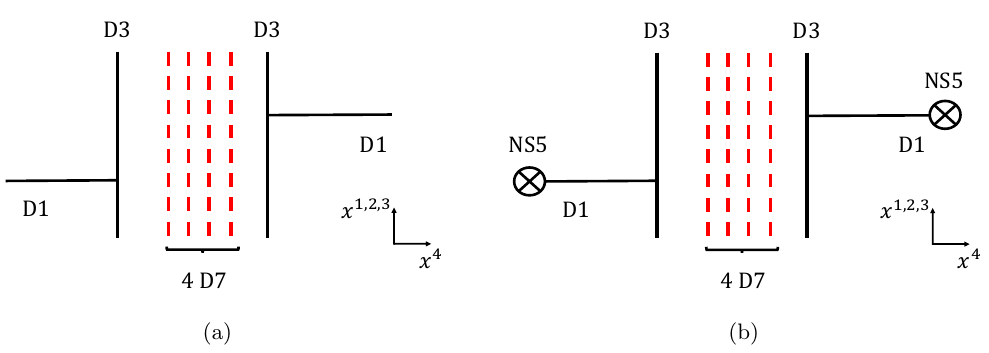
Figure 1 . (a) A brane con(cid:12)guration for the ’t Hooft operator with magnetic charge B = (cid:0) e 1 + e 2 in the U(2) theory with four (cid:13)avors. Vertical (horizontal) solid lines represent D3-branes (D1- branes). Dotted red lines represent D7-branes. (b) Another con(cid:12)guration for the same